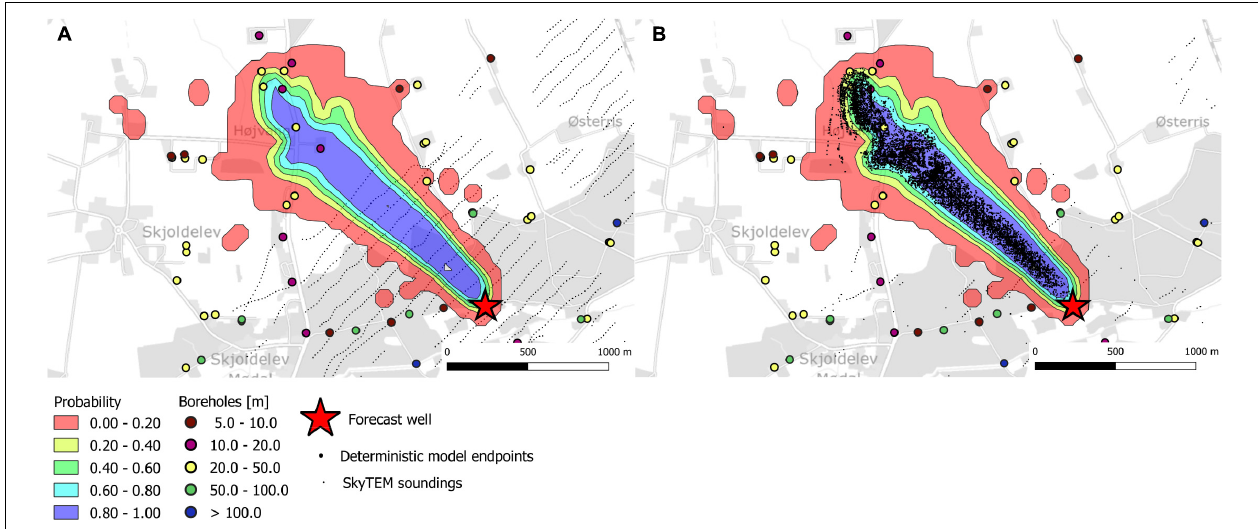
FIGURE 12 | Probability plots of well catchment zones for the Ristrup well estimated from the 4-cluster model realizations. (A) Catchment probability, (B) Probability map overlaid with catchment from deterministic